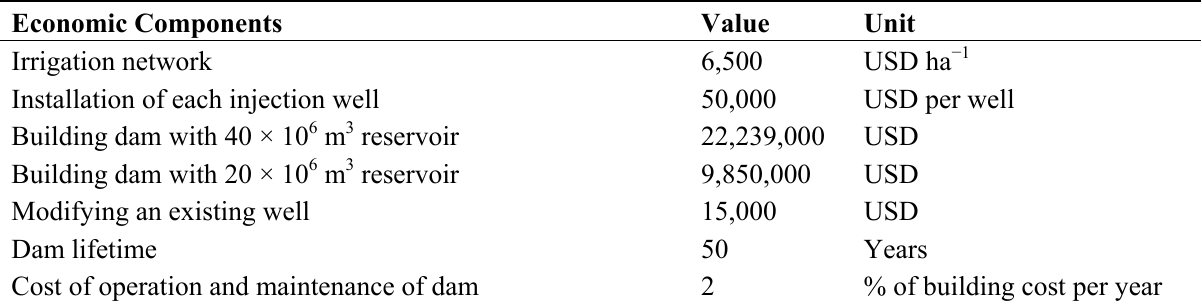
Table 3. Potential costs involved in the aquifer storage and recovery (ASR) project in Sirik,